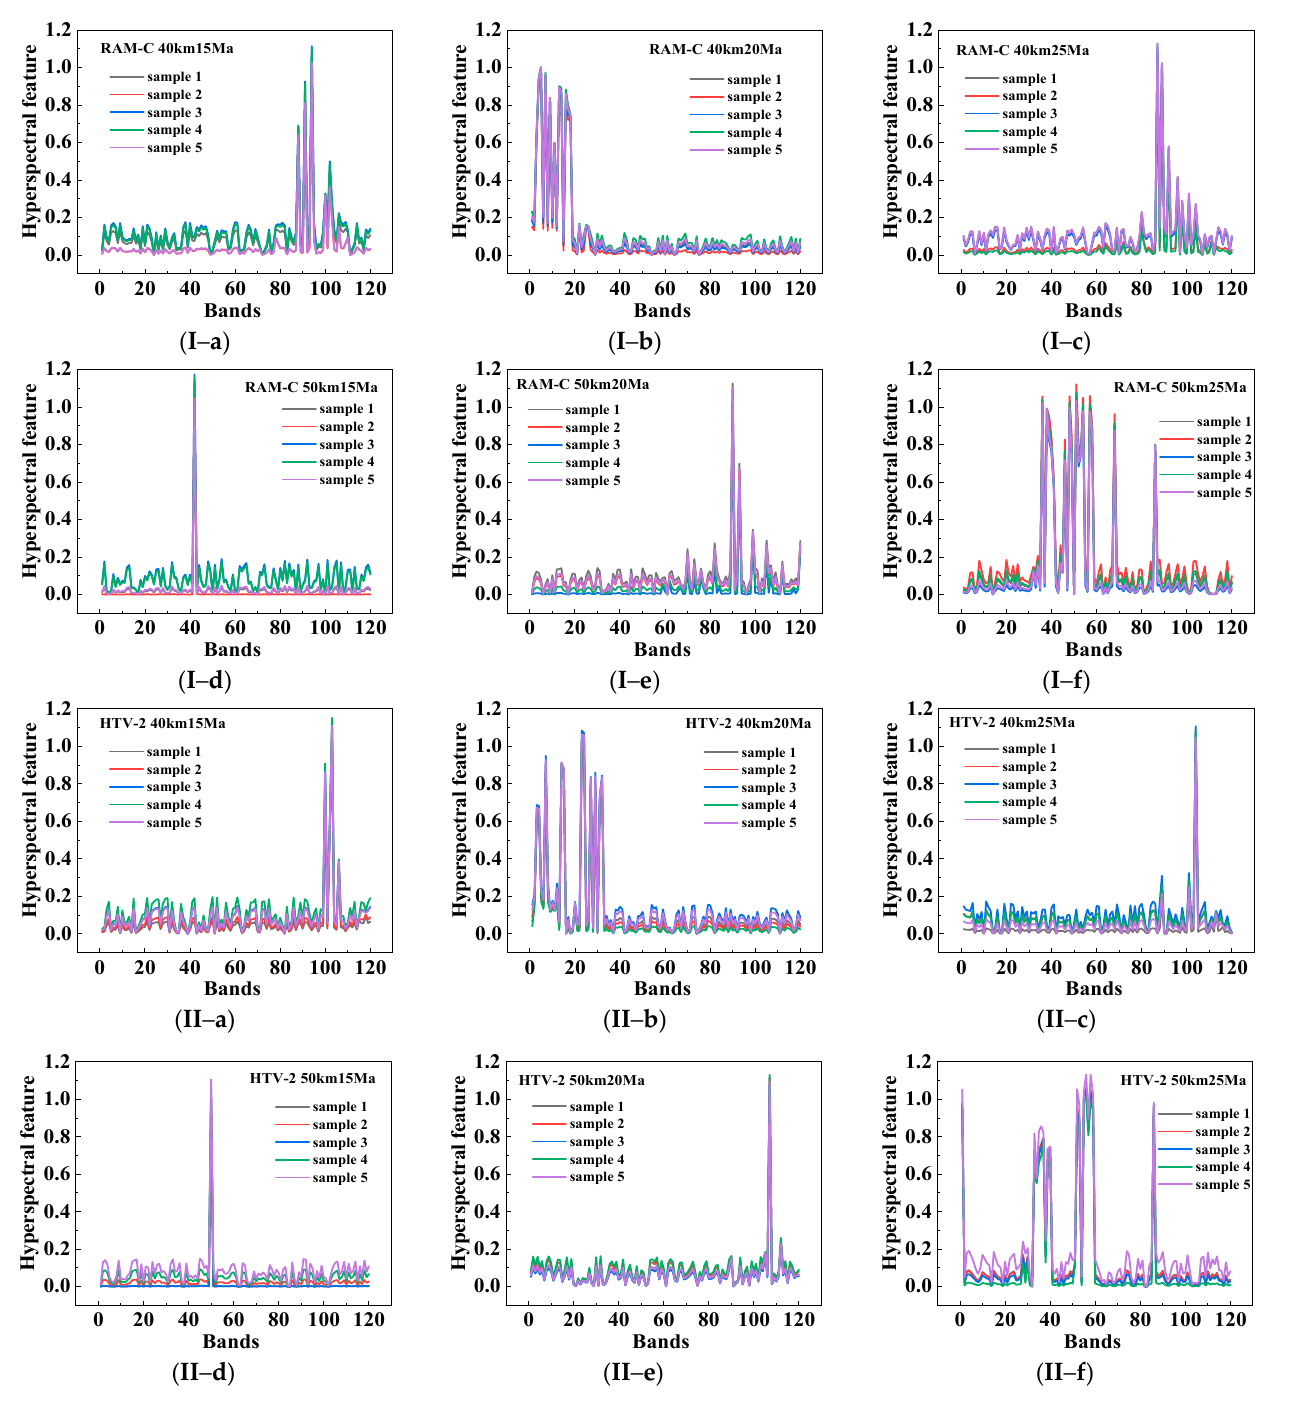
Figure 10. The simulated observation samples for each flight state of RAM-C II and HTV-2. ( I ) RAM- C II. ( II ) THV-2. ( a ) 40 km 15 Mach. ( b ) 40 km 20 Mach. ( c ) 40 km 25 Mach. ( d ) 50 km 15 Mach. ( e ) 50 km 20 Mach. ( f ) 50 km 25 Mach.